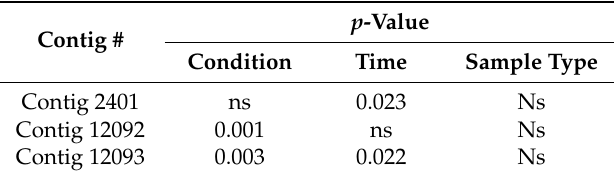
Table 2. Fisher’s exact test results for viral contigs comparing condition (SSWD-a ff ected vs. grossly normal), sampling time (initial, time of lesion formation, time of death or experiment termination), and sample tissue type (control, artificial scar, wasting lesion). Only contigs returning any significant ( p < 0.05) result are